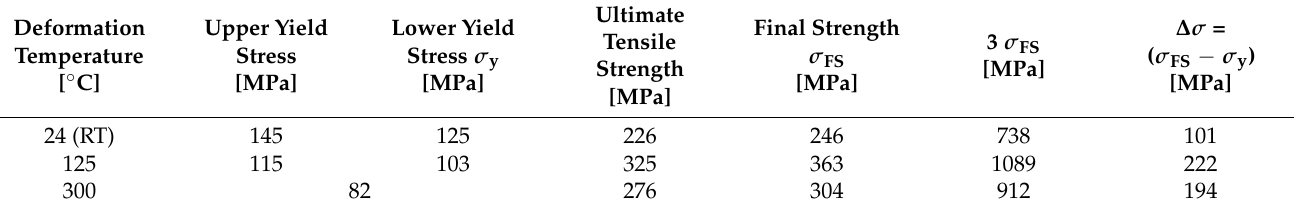
Table 4. Tensile properties from tensile pre-deformation tests and corresponding hardness according to Tabor’s predictions.